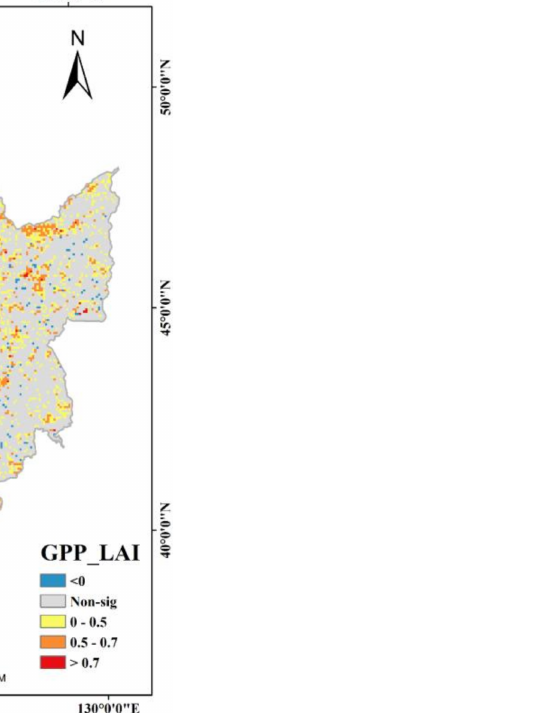
Figure 7. Spatial distribution of the correlation coefficient between GPP GS and LAI GS across the entire